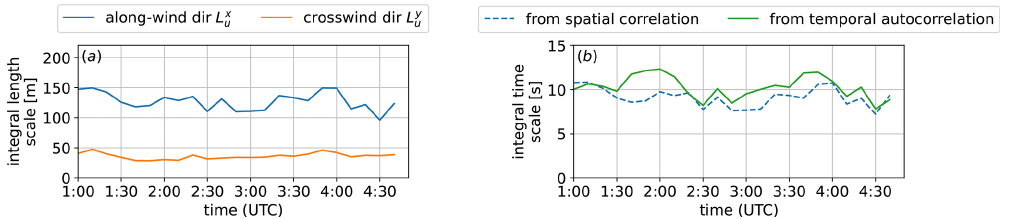
Figure 8. Integral scales variation in the 4h period of interest from LES. (a) Integral length scale of the streamwise component of the turbulence u for the along-wind direction ( L x u ) and crosswind direction ( L y u ); (b) along-wind integral timescale calculated separately from spatial-correlation and temporal-autocorrelation